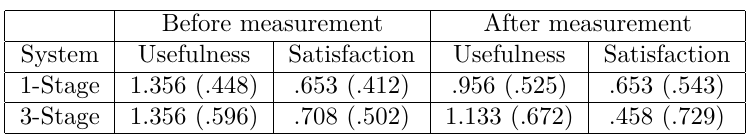
Table 6. Van der Laan – Pre-and Post Scores